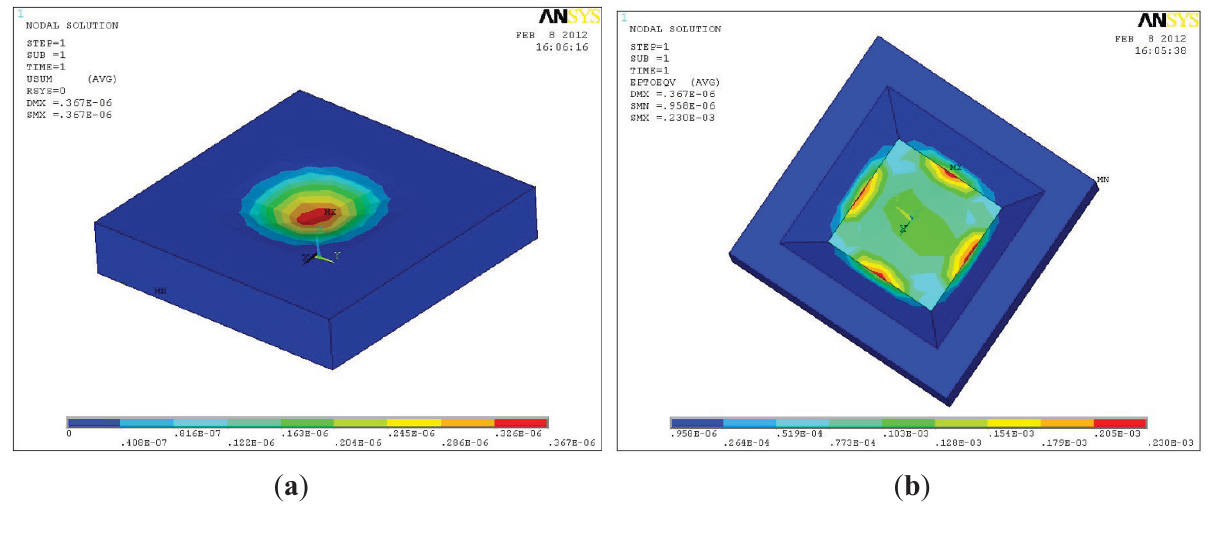
Figure 3. The deformation of the micro-force sensor with pressure 200 KPa applied on